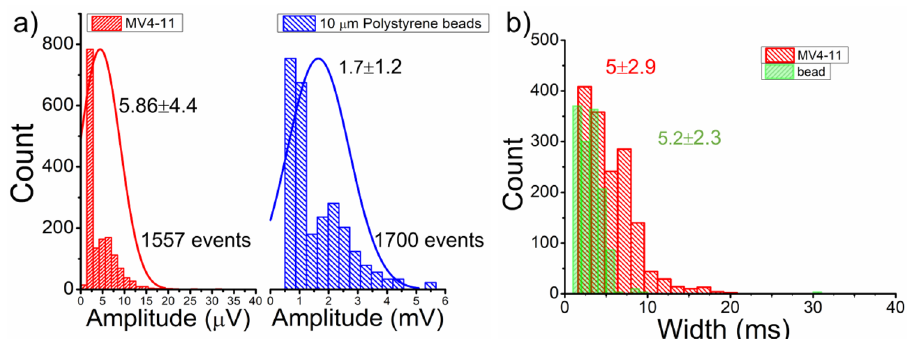
Figure 11. Histogram for the spike amplitude and pulse width for a heterogeneous population of leukemia cells and 10 µm polystyrene beads for 800 s recorded data with several events with curves shows normally distributed fitting results.